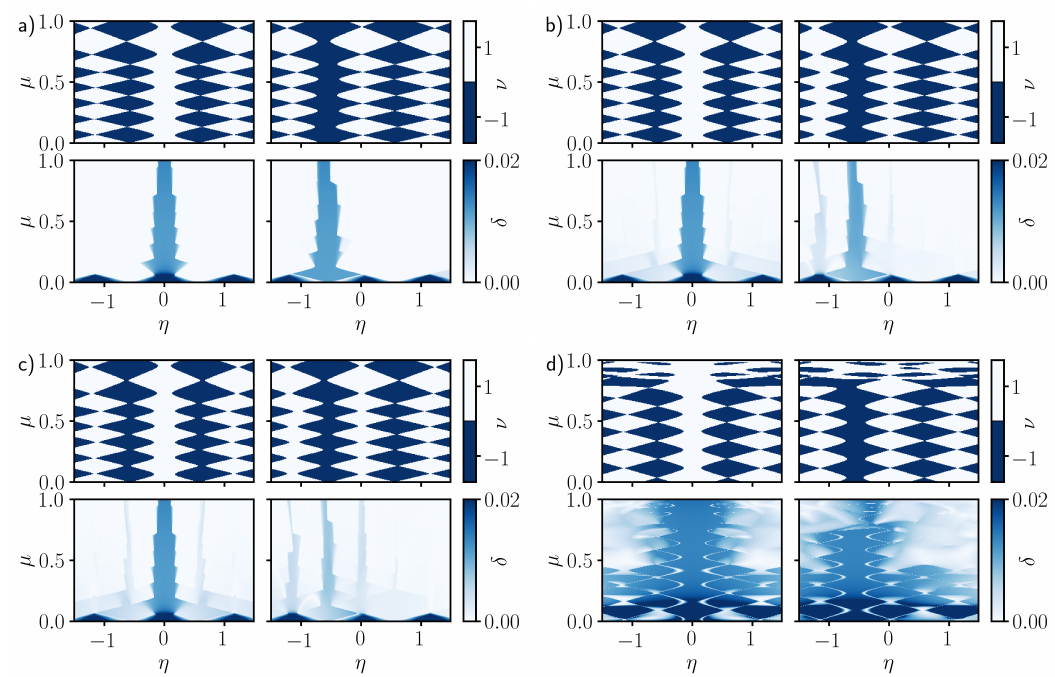
Figure 5: Phase diagram and gap obtained from the tight binding model in the pres- = 0.02. Subpanels are arranged in the same way as in ence of flux, with pairing ∆ 0 Fig. 3 where analytical results are shown. a) Results for a clean, square wire with = N = 10. b) Results in the presence of an asymmetric supercurrent profile, N x y which is modeled by choosing the origin of the gauge potential offset from the center = 2.25) . c) Results for a disordered wire with W = 0.1. d) Results of the wire ( x 0 for a disordered wire with W =